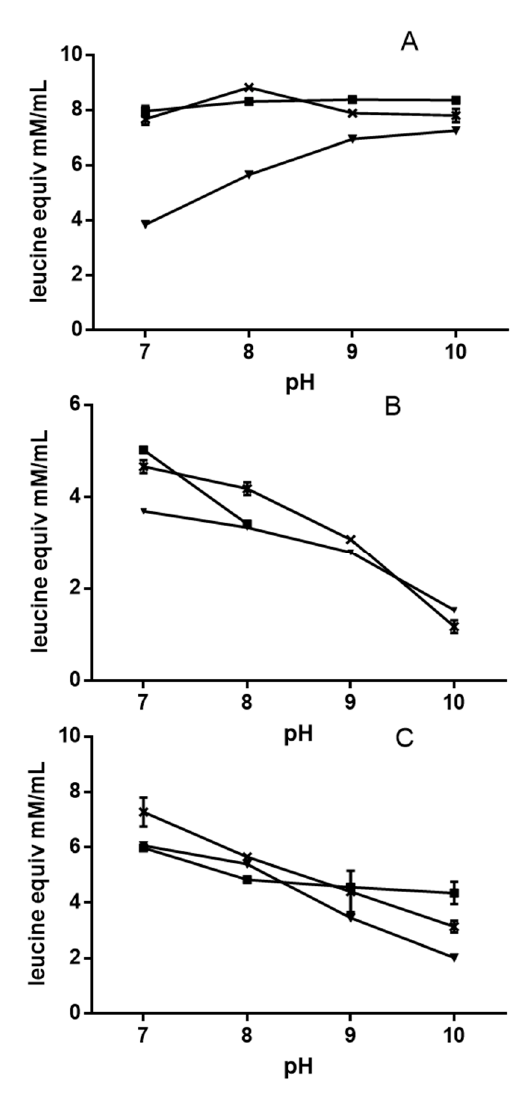
Figure 3. Leucine equivalents produced at different pH levels and temperatures by three enzymes (substrate enzyme ratio 1:10). ( A ) alcalase; ( B ) flavourzyme; ( C ) protamex. Temperatures: 40 °C ( ▼ ); 50 °C (×); 60 °C ( ■ ). Results (mean ± SD) are expressed as mM/mL of supernatant after 10 min of hydrolysis (n =